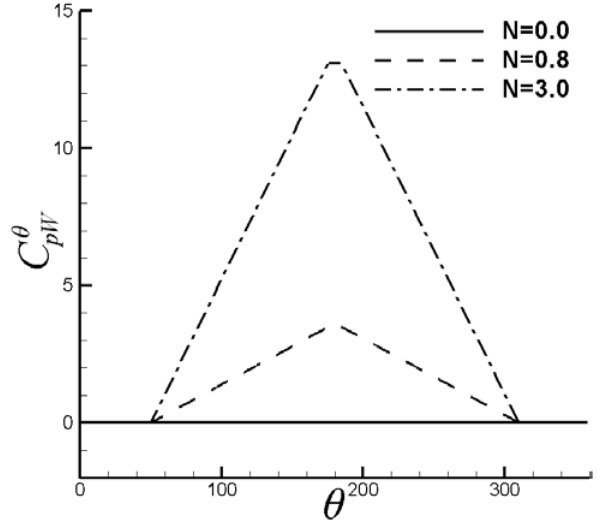
θ C with Lorentz force controls. Figure 8. Distributions of pressure coefficient C θ with Lorentz force pW pW